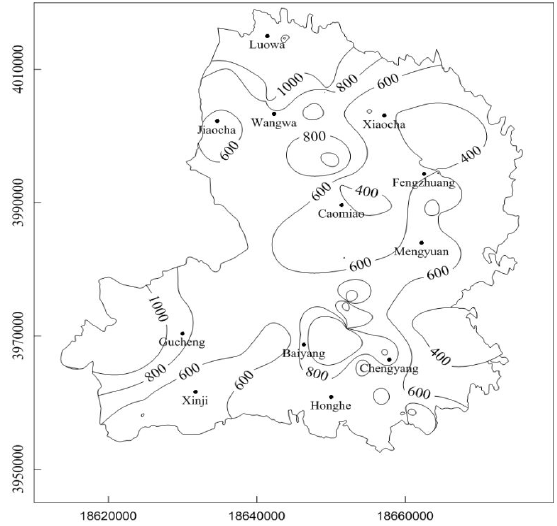
Figure 2. Contours map of TDS in Pengyang drinking